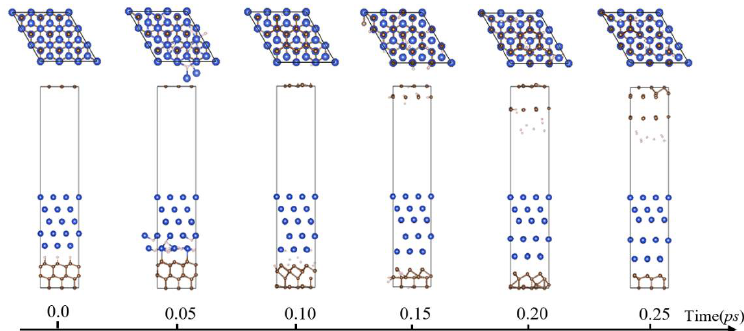
Figure 7. Molecular dynamics simulation of diamond (111)/Cu (200) interface.